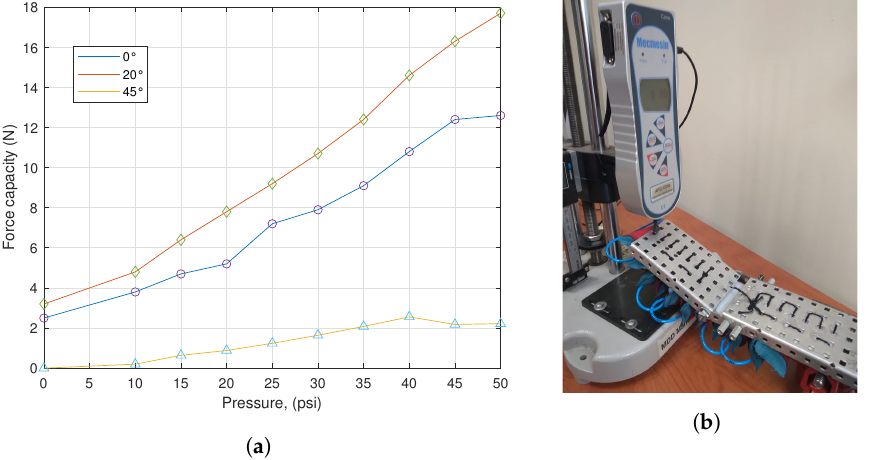
Figure 9. FISAs payload capacity test. ( a ) Pressure vs. Force test. ( b ) Force Gauge and FISAs